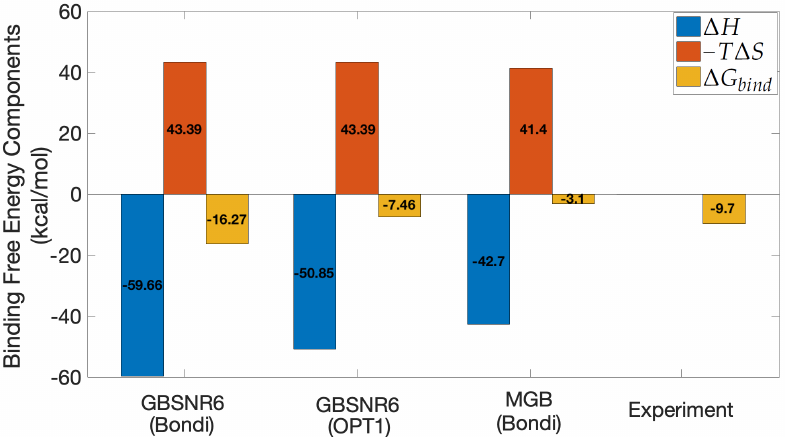
Figure 9. MM/GBSA results for Ras-Raf. The experimental value is from isothermal titration calorimetry [72]. An offset of 1.79 kcal/mol has been subtracted from the ∆ H component of MGB- based estimate [28] for consistency with the author’s